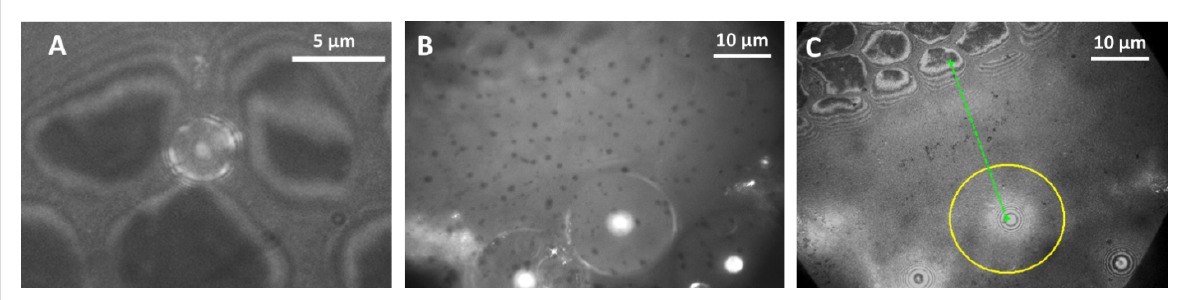
Figure 4: IRM images of the toe pad in contact around a glass bead. Interference fringes indicate the pad sloping away from the glass surface, due to the presence of a bead nearby. A) displays how smaller beads get trapped in the channels between the cells of the pad. B) and C) show two images taken at different focal planes; B) allows the circumference of the bead to be seen, which can then be recorded and superimposed on the second focal plane (C). The horizontal distance from the centre of the bead to the centre of the closest cell in close contact with the glass is marked by a green dashed line. The dark central part of each toe pad epithelial cell is the zero order dark fringe, representing a pad-glass distance of at most a few nanometres and is used as the starting point of the distance measurement, while the centre of the bead is the end